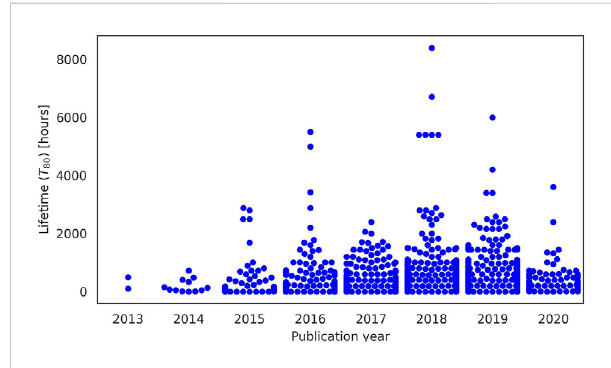
FIGURE 1 Lifetime T 80 in hours of every perovskite solar device published between 2013 and February 2020 (for which T 80 was reported in the Perovskite Database). The vast majority of devices reported, 1,790 out of 1,834, have a short lifetime of at most 2,000